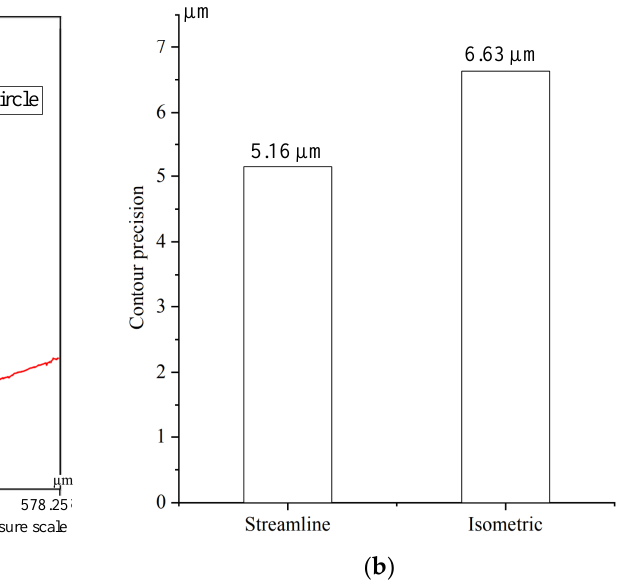
(c) Figure 14. ( a ) Micro-fillet 3D image, ( b ) multilinear roughness measurement and ( c ) multilinear roughness result. Five parts at the same position of the micro-fillet samples from the two machining strategies were selected; three sets of contour accuracy were measured at each position. As the radius of the micro-fillet was expected to be 0.2 mm, the contour of each section of